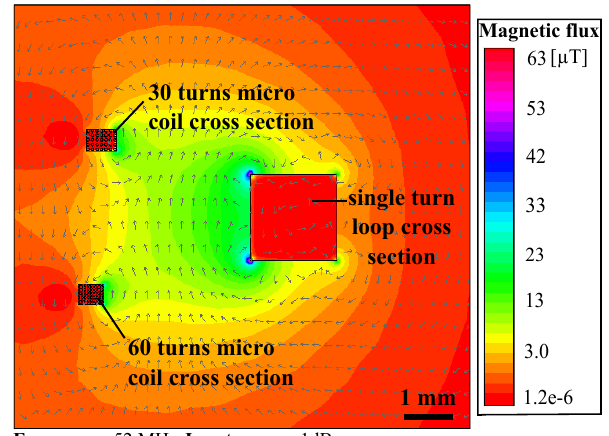
Figure 17. 2-D FEM simulation of 60- and 30-turn micro coils cou- pled to a small loop antenna.